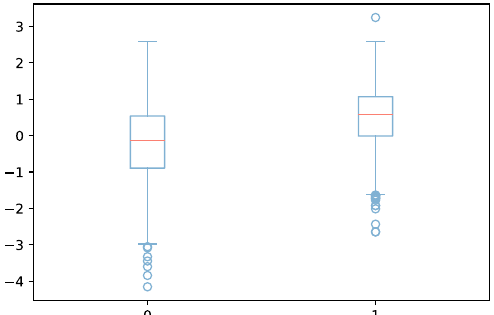
Fig. 6 Boxplots of aggregate money raised (log) for ‘traditionally successful’ (right; 1) and ‘traditionally unsuccessful’ (left; 0)